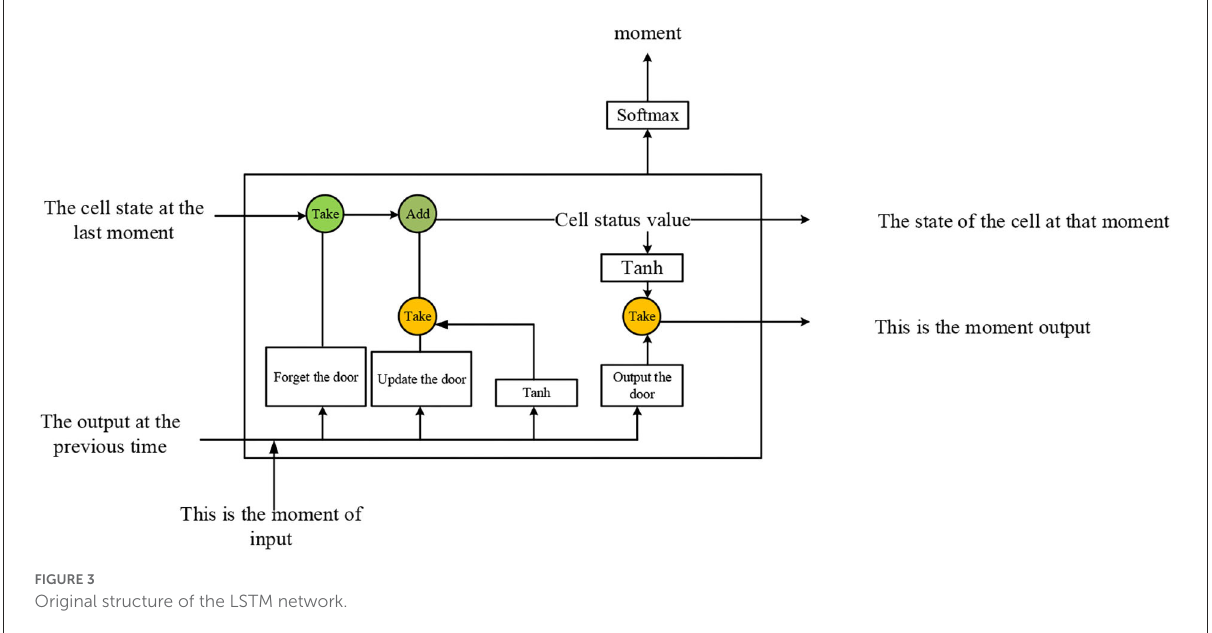
FIGURE3 Original structure of the LSTM